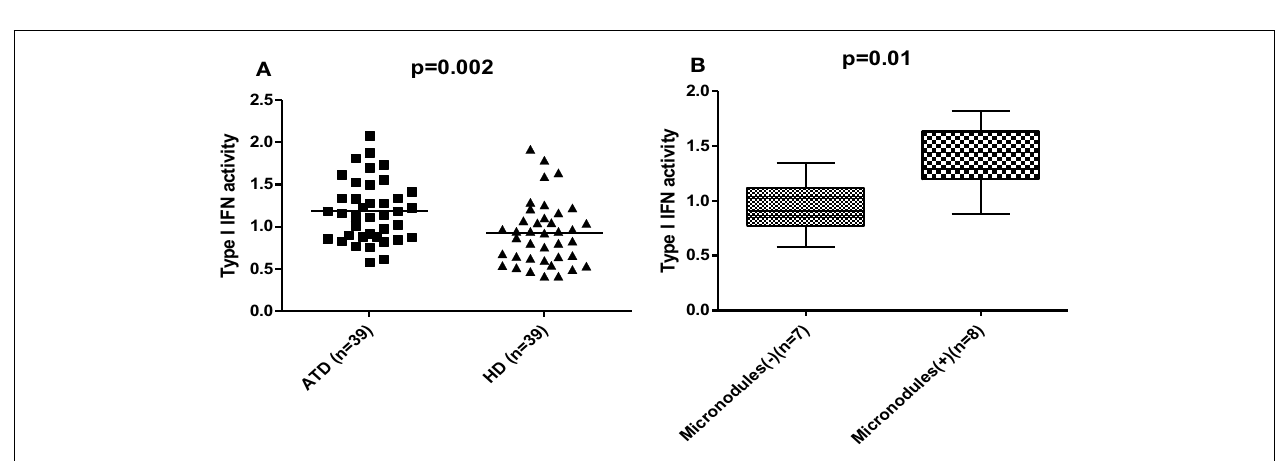
ultrasonographic presence of thyroid micronodules. Serum type I IFN activity assessed using a sensitive reporter cell assay was found to be higher in ATD patients characterized by the presence of micronodules on ultrasound ( n = 8) compared to those without such nodules ( n = 7). Data are shown as box plots. Each box represents the 25–75th percentiles. Lines inside the box represent the median. Lines outside the box represent the 10th and the 90th percentiles; p -values were calculated by unpaired t -test. Micronodules ( + ): presence of micronodules, micronodules ( − ): absence of